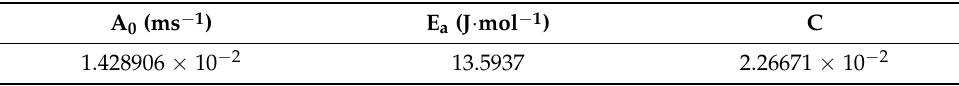
Table 6. PTFE/Al chemical kinetic equation parameters.